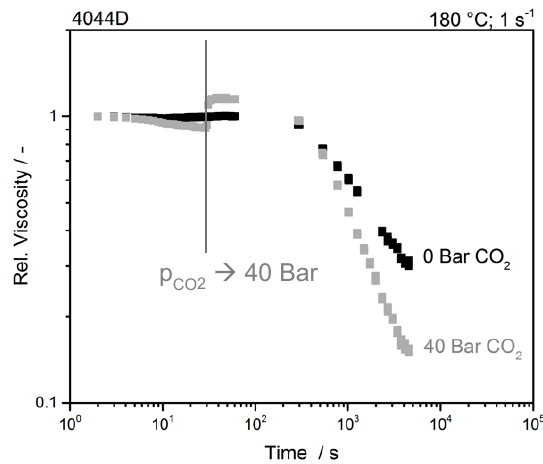
Figure 4. Time sweep of unmodified PLA with and without the presence of CO 2 .